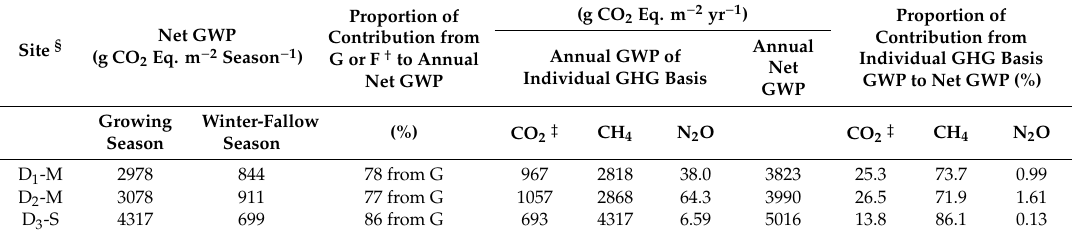
Table 8. Proportion of contribution from seasonal net GWP and annual GWP of individual GHG to annual net